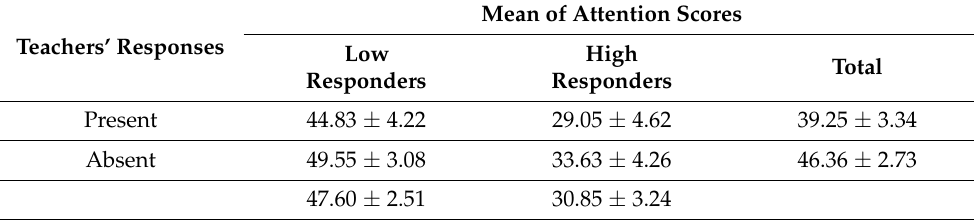
Table 2. Mean of attention scores by groups according to teachers’ opinions as a possible risk population and recording of the software of the Pinky-Piggy application videogame. The rows show the mean of attention (in percentile score) of students marked as present (attentional problems) or absent according to the teachers’ opinions. The columns display the same information under the Pinky-Piggy app. The table indicates that the software was more sensitive in discriminating between participants. In fact, the last column (total) shows a similar percentile between Present and Absent. Mean of Attention Scores Teachers’ Responses Low High Total Responders Responders sponses Present 44.83 ± 4.22 Absent